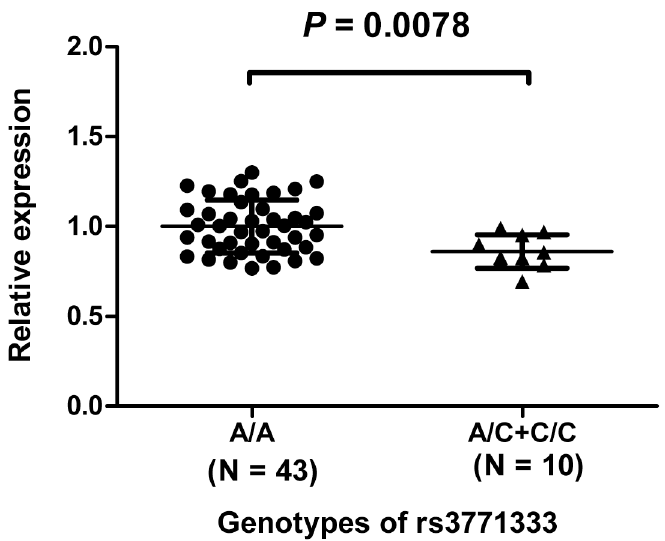
Fig 1. Semiquantitative PCR for HJURP . Expression of HJURP for the three different genotypes of rs3771333 was measured in RNA from Epstein-Barr virus (EBV)-transformed blood lymphocyte cell lines derived from 53 unrelated Chinese individuals. Forty-three individuals carry A/A, 9 carry A/C and 1 carrys C/C genotype. Normalization for mRNA quantity was performed with human GAPDH control primers for each sample. The horizontal bars indicate the mean values for each genotype, with the mean value of A/A carriers designated as 1. We found that the expression of HJURP mRNA in C allele carriers had a lower level compared with the A/A carriers ( P = 0.0078; t test).